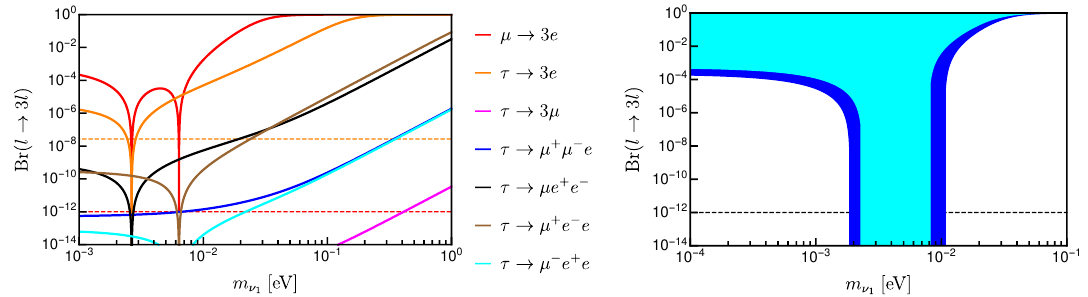
Figure 2 . Yukawa couplings h ij as function of the lightest neutrino mass, calculated with F These Yukawas should therefore be understood as lower limits . In both plots we have used the best (cid:12)t point data from the global oscillation (cid:12)t [39], except (cid:14) = 0. The plot to the left shows the case